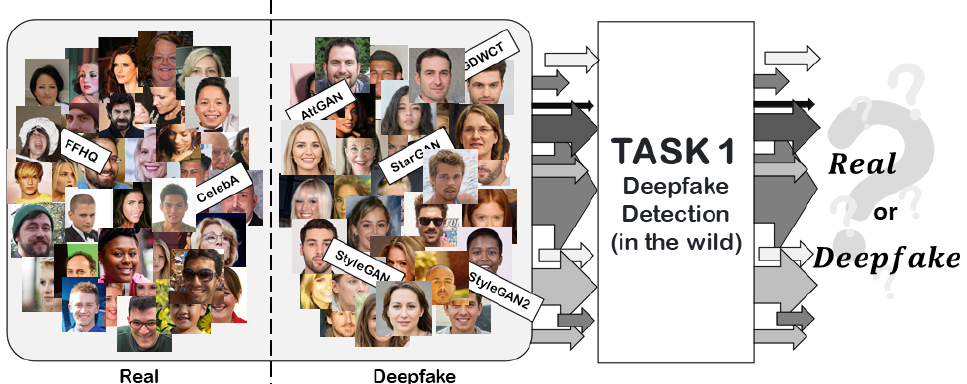
Figure 2. Task I: Deepfake detection task. Given a set of Real and Deepfake images created by different GAN engines, the objective is to create a detector able to correctly classify Deepfake images in any